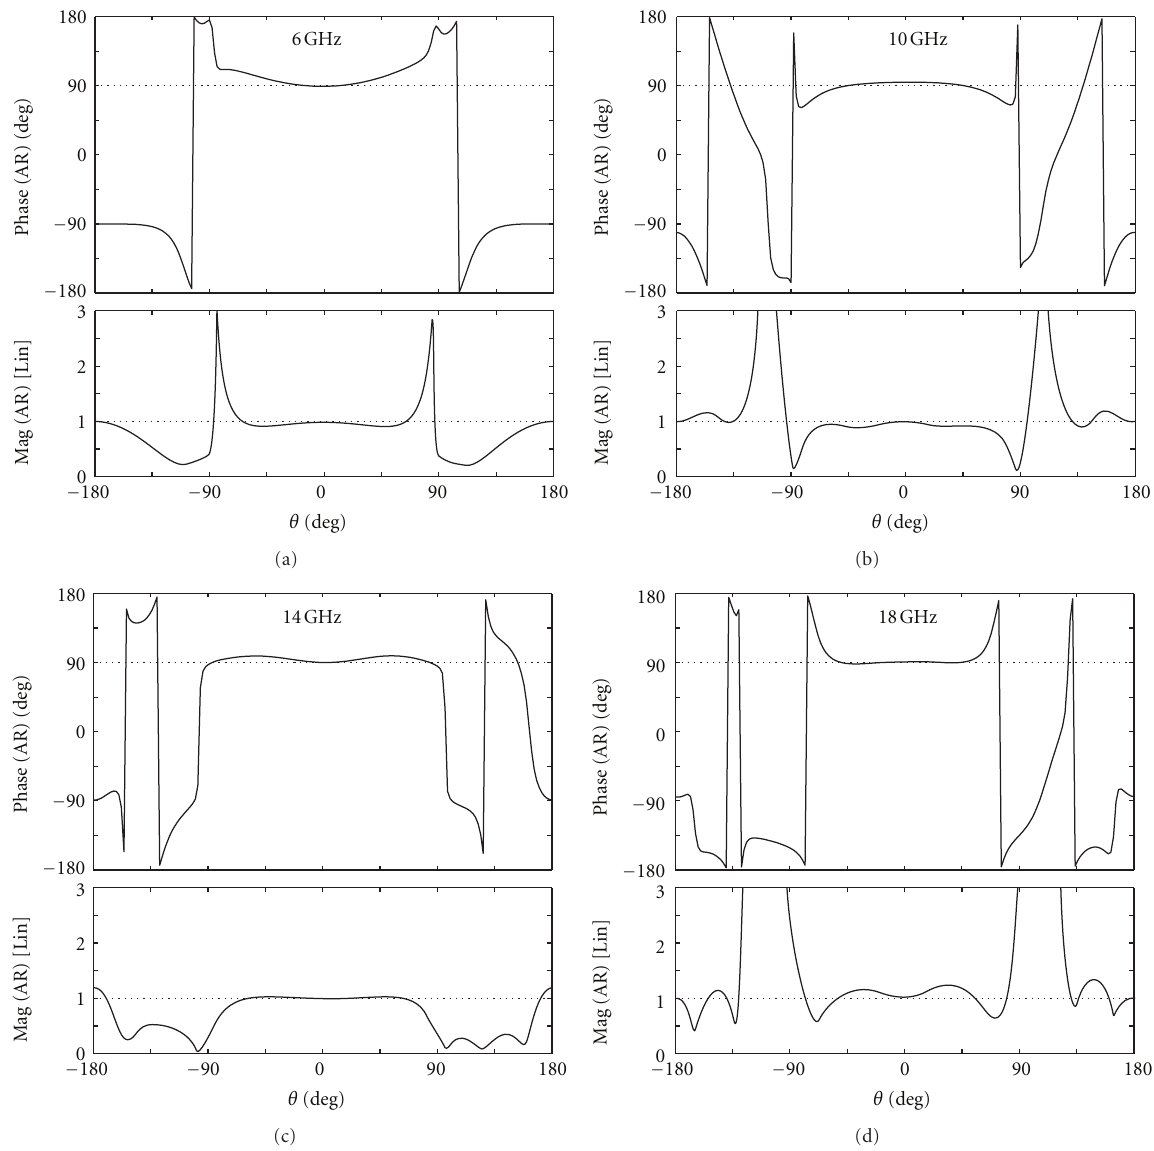
Figure 9: Axial ratio (AR) and phase between the two orthogonal components for the proposed slot